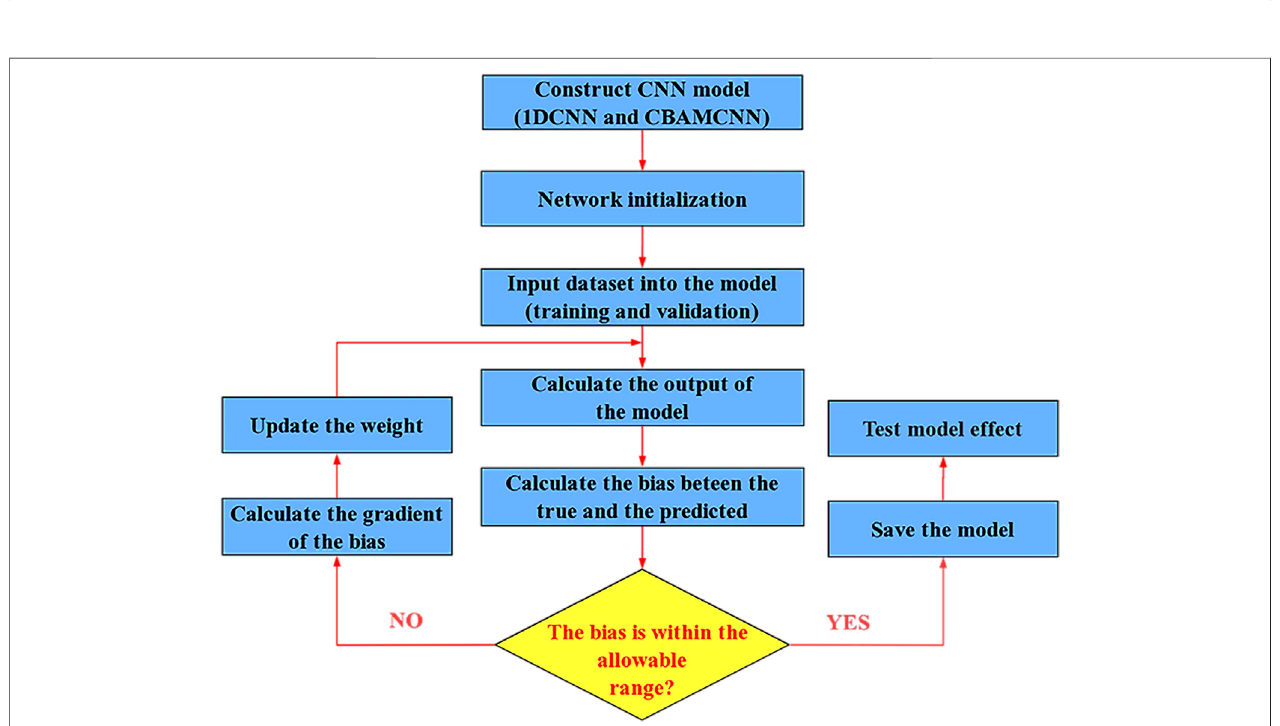
FIGURE 4 | Training process of the baseline model (1DCNN) and the improved model (CBAMCNN).